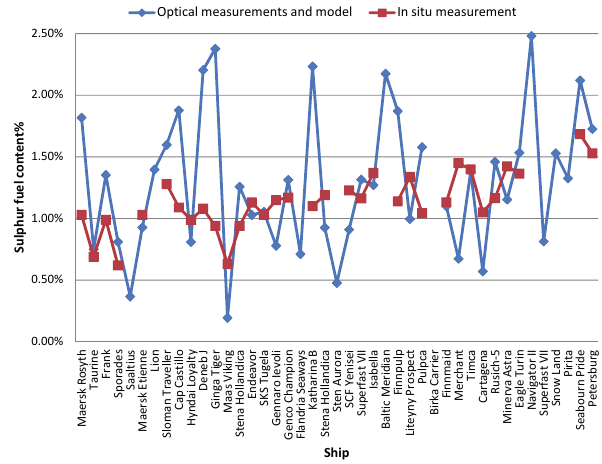
Fig. 14. Emisson rates of SO 2 from the FMI-STEAM model versus optical mearurements. The model overestimates the emissions by 18% and the correlation coefficient ( R 2 ) corresponds to 0.63.